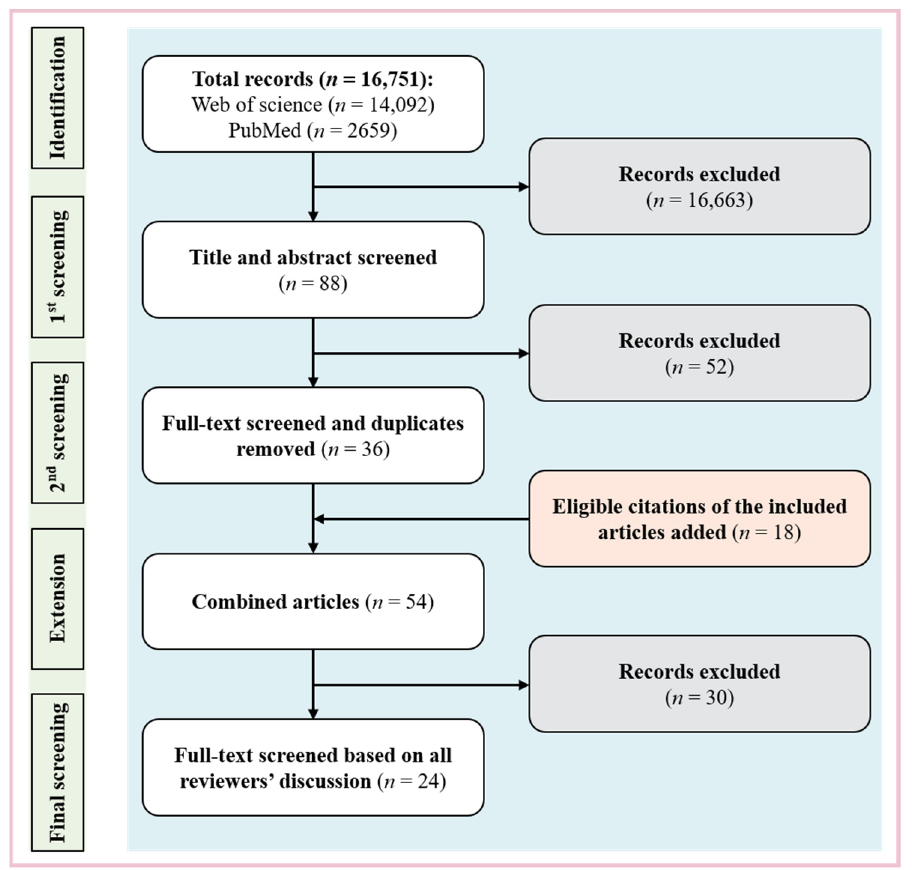
Figure 1. Flow chart of study inclusion.